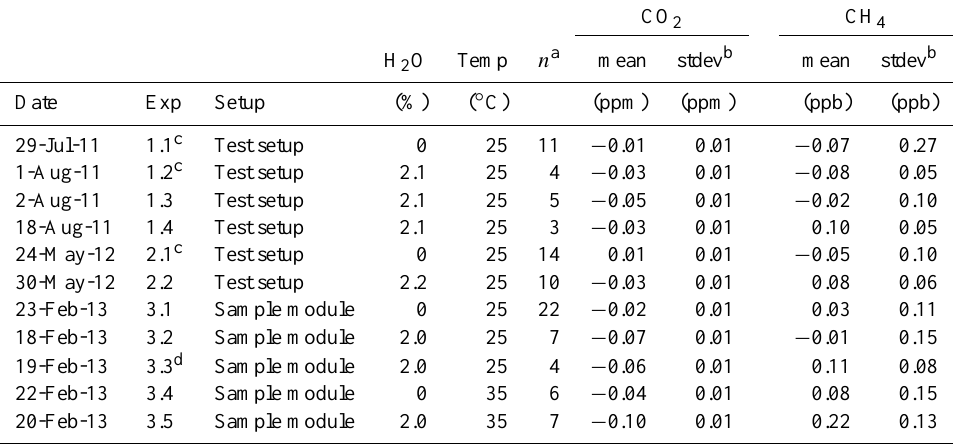
Table 1. Mid-point differences between Nafion and cryotrap treatments (Nafion minus the mean of cryotrap measurements before and after).